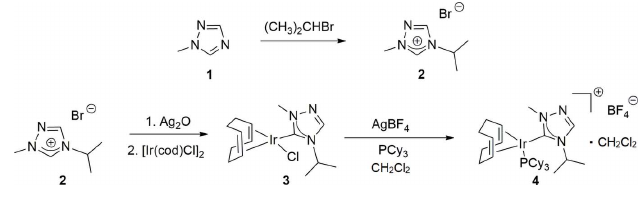
Figure 3 Reaction scheme for the synthesis of the N-heterocyclic carbene ( 2 ) and subsequent formation of the title compound ( 4 ).